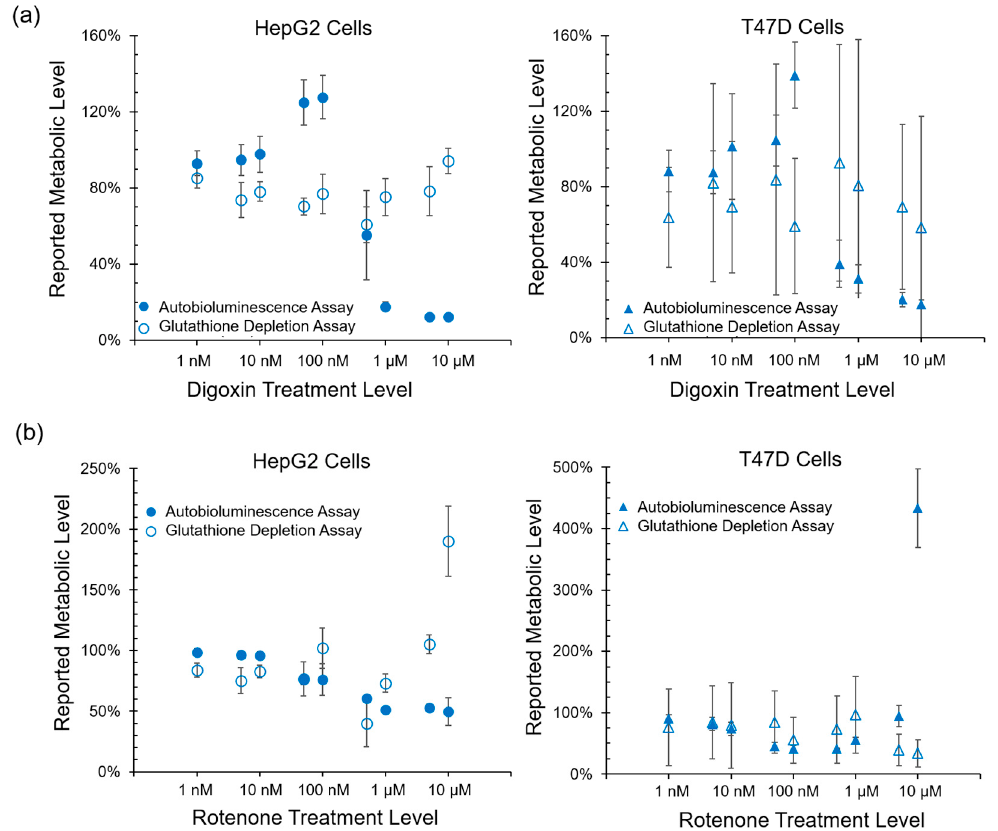
Figure 4. No correlation was observed between the results of autobioluminescent assays and glutathione depletion assays for any of the compounds tested. Values are the averages of triplicate tests, with error represented as